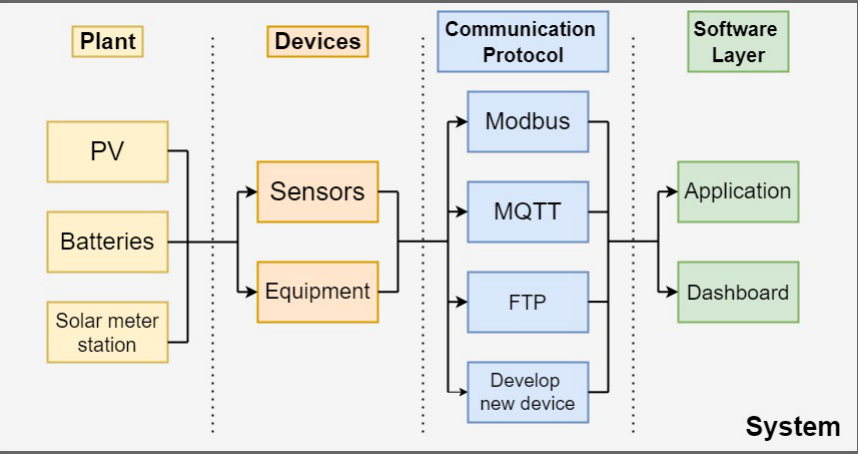
Figure 11. Flowchart of the development of the supervisory system including the steps necessary for the configuration of the communication